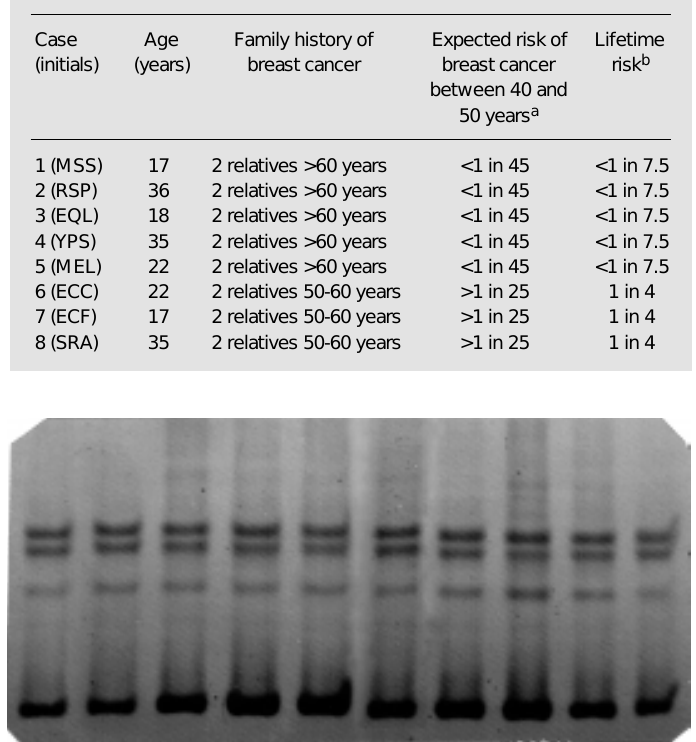
Figure 1 - Single strand of exon 8 of gene TP53. Polyacrylamide gel with 10% glycerol. The gel was stained with silver nitrate. Single-strand conformational polymorphism did not show any polymorphism indicating